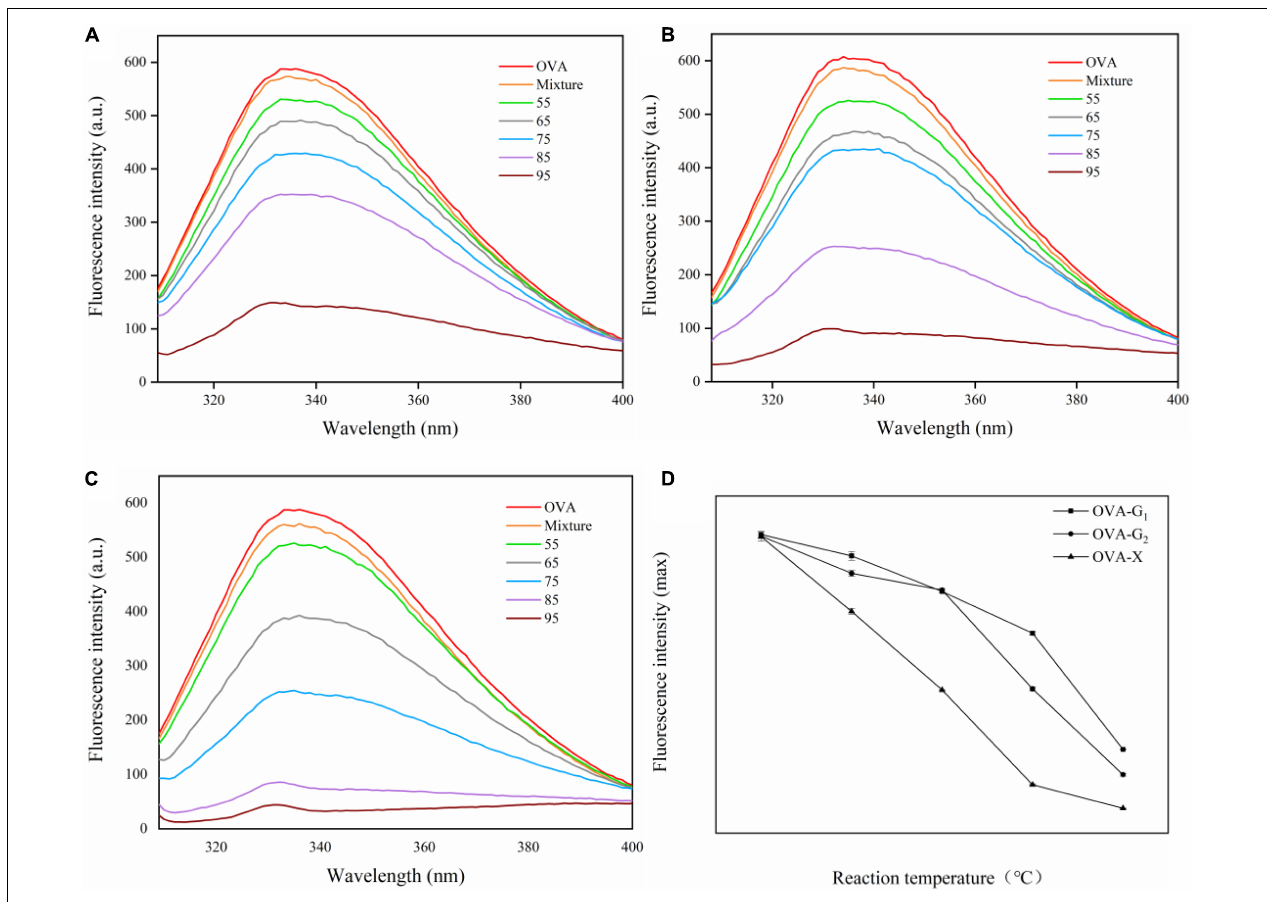
FIGURE 3 | The intrinsic fluorescence spectra (A–C) and the maximum absorption wavelength of the conjugates (D) of OVA, OVA-G 1 , OVA-G 2 , and OVA-X at different reaction